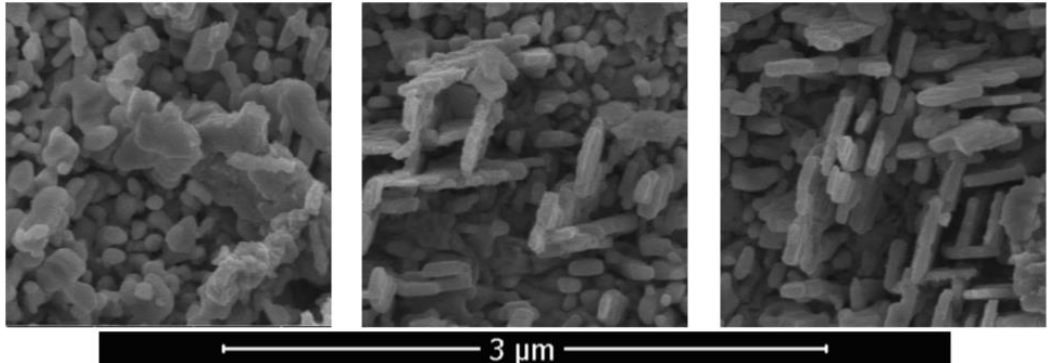
Figure 9. Disordered structure of the central region (on left ), intermediate hybrid structure (in the center ) and two-dimensional objects (on right ). Sensors 2020 , 20 , x FOR PEER REVIEW